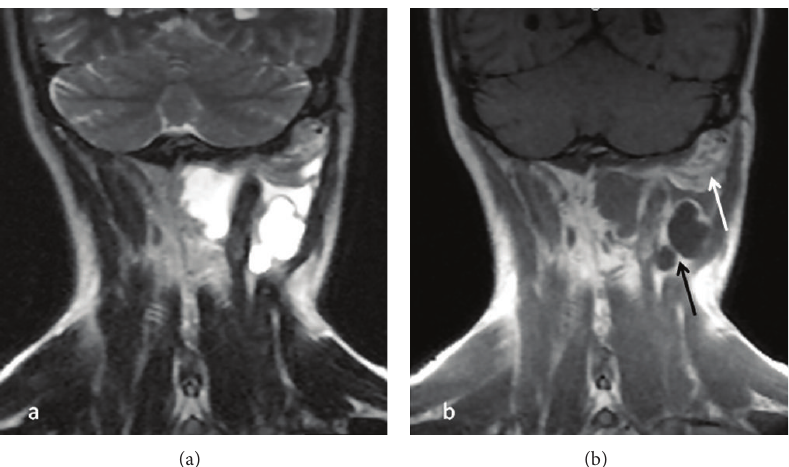
Figure 1: MRI findings of a 38-year-old male showed a multilobular cystic mass that was 8 × 5 × 4 cm and extended from the mastoid bone’s posterior border along the sternocleidomastoid muscle to the larynx and was hyperintense on T2-weighted images (a) and hypointense on postcontrast T1-weighted images (b).